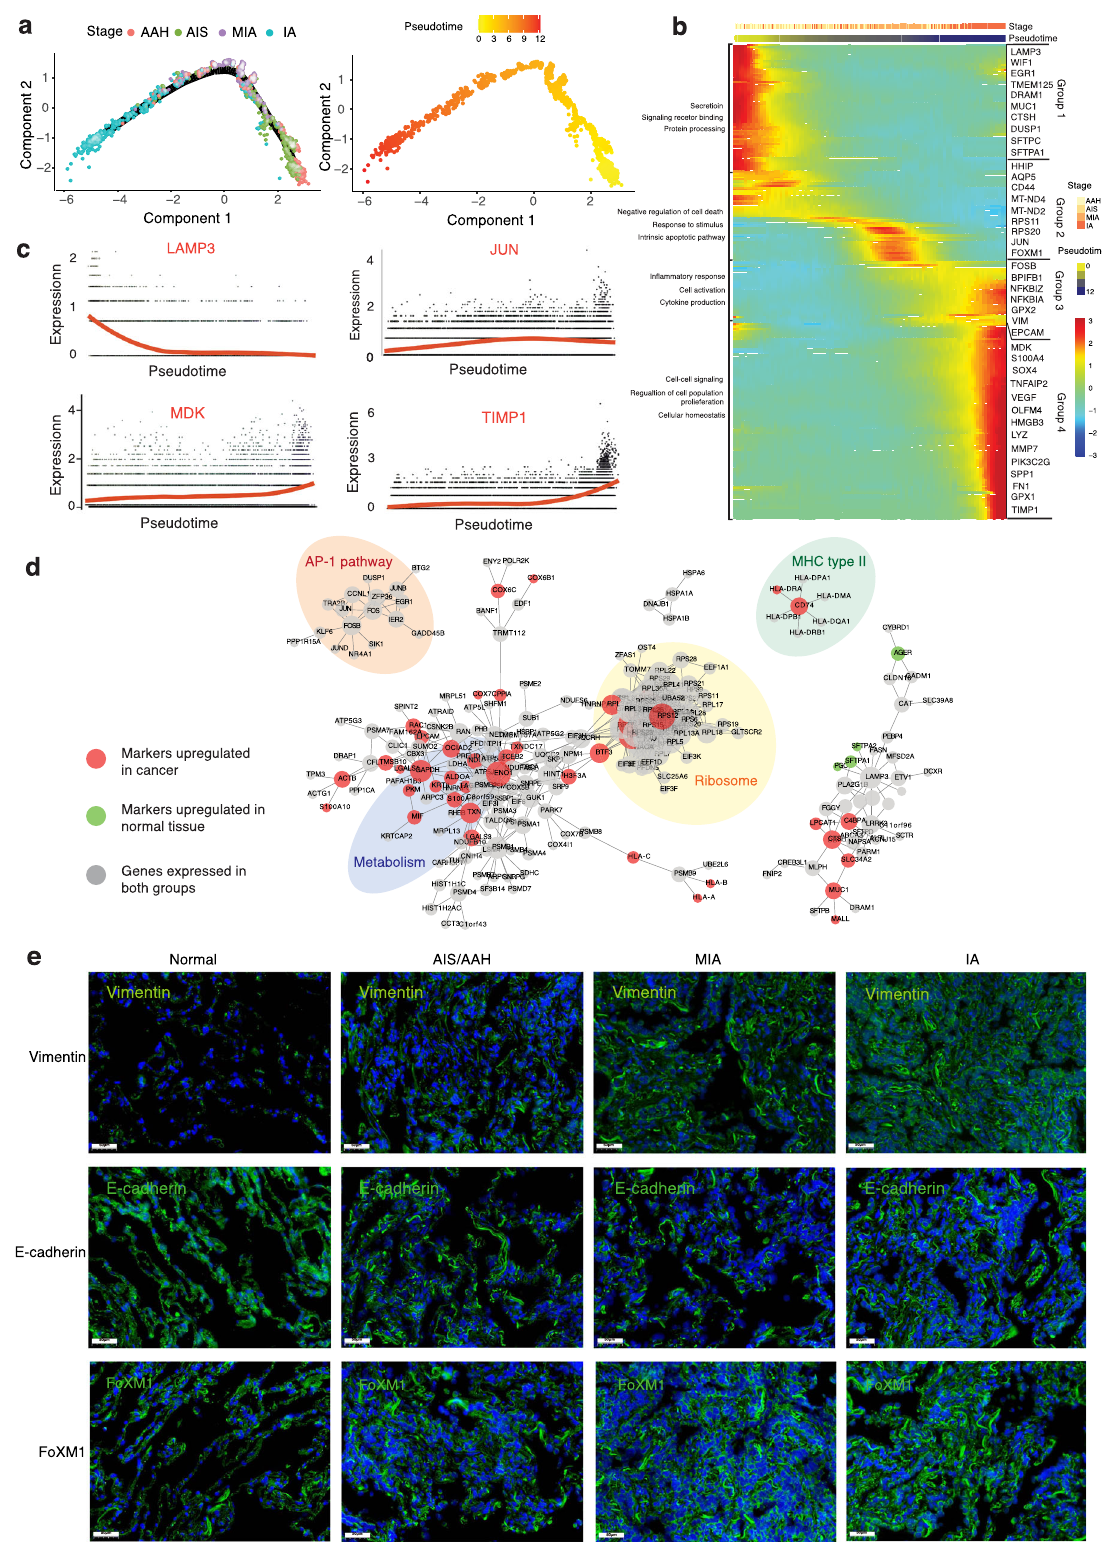
Fig. 3 Transcriptional trajectory analysis of AT2 cells. a Trajectory analysis of AT2 and AT2-like cell clusters. Cells were color-coded by histologic stages or pseudotime. AT2: alveolar type 2 cells. b Heatmap showing 283 differentially expressed genes arranged in pseudotemporal patterns. Gene Oncology terms from the enrichment analysis revealed biological functions of cells in the four groups indicated. c Representative gene expression levels of different marker genes. The size of each dot represents relative expression levels. d Gene-gene interaction networks between marker genes in AT2 and AT2-like cell clusters. e Fluorescent in situ hybridization staining for Vimentin , E-cadherin , and FoXM1 in normal tissues and tumor tissues from different stages. Each staining in panels come from three samples. Scale bars: 50 μ m, nuclei (DAPI) are stained